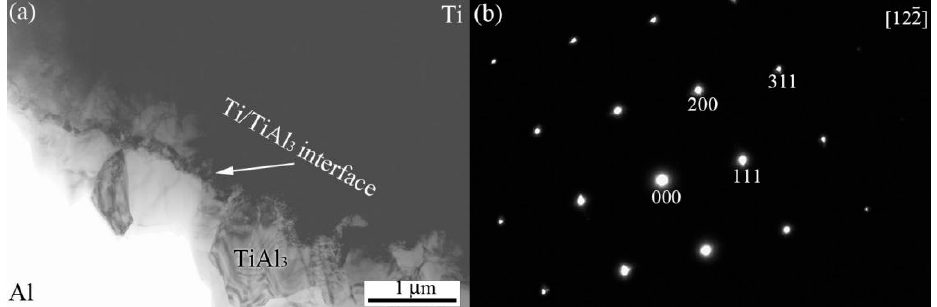
Figure 3. Interfacial zone TEM images of the Ti-Al sample annealed for 1 h at 873 K ( a ) and the electron diffraction patterns taken form the IMC layer ( b ).